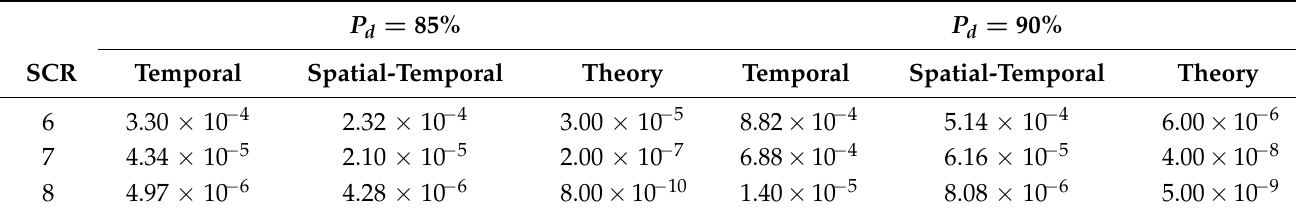
Table 2. P f achieved by three methods under different SCRs and P d